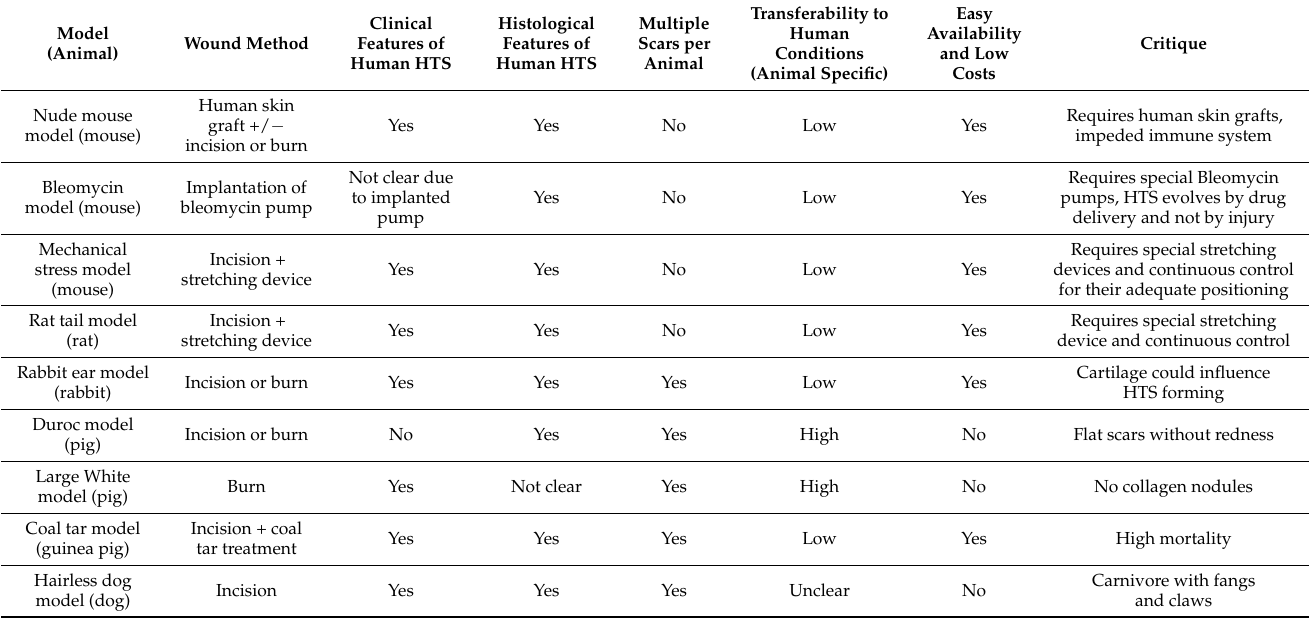
Table 1. In vivo models in hypertrophic scar research summarizing the advantages and disadvantages thereof.